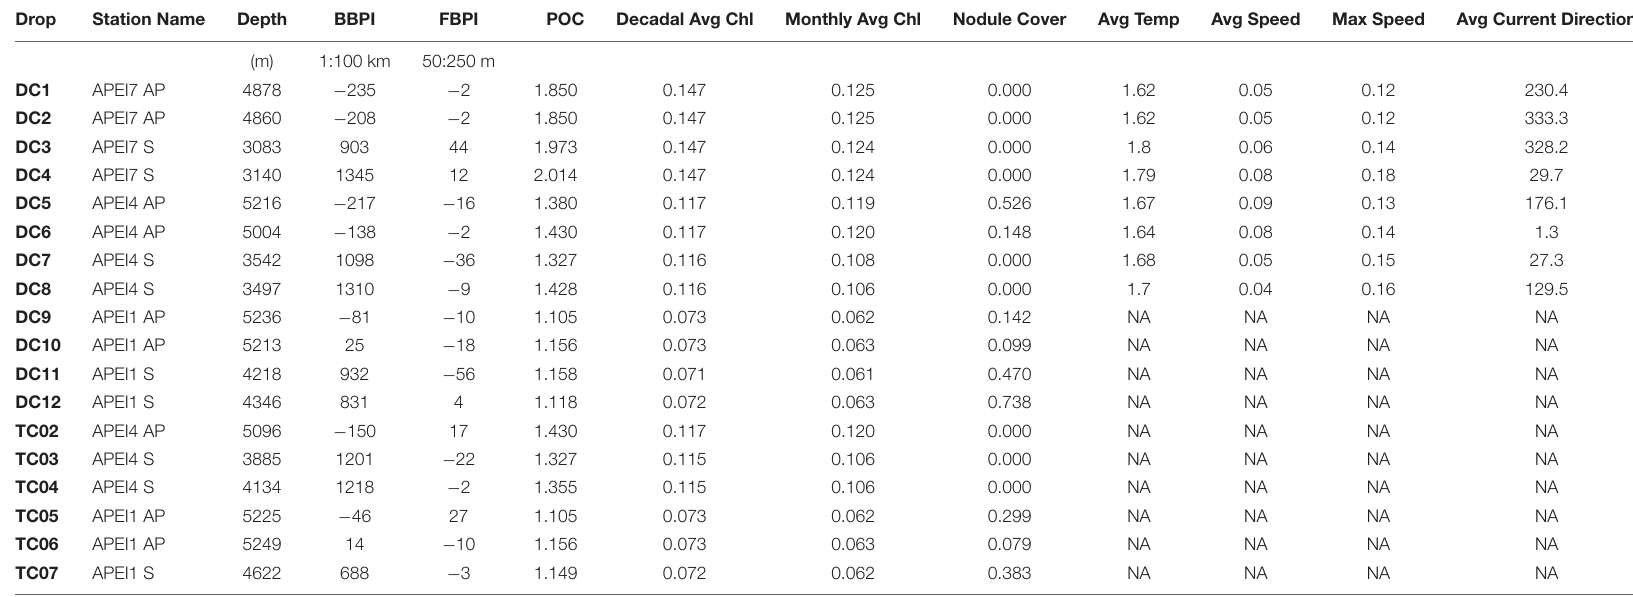
TABLE 2 | Environmental characteristics for all camera